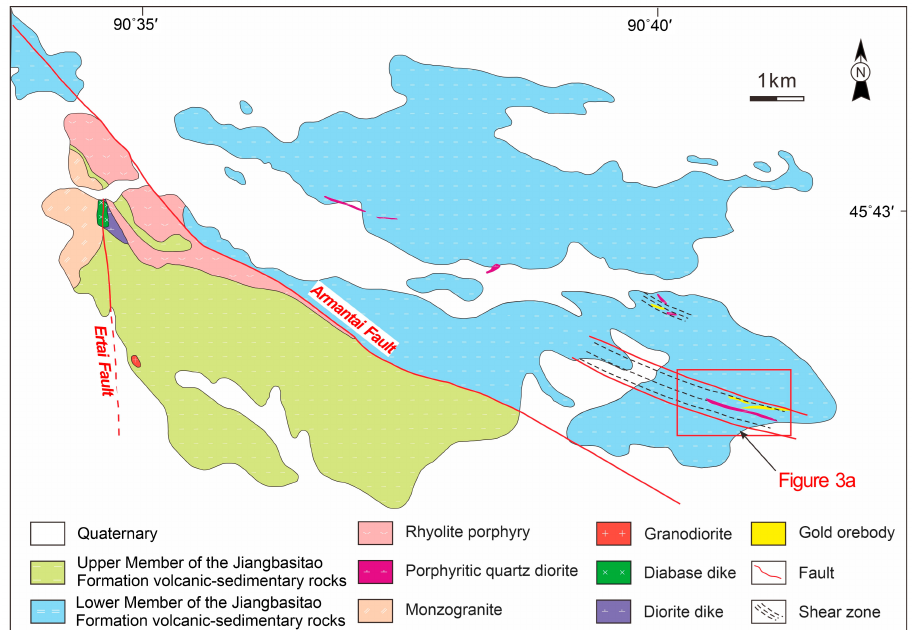
Figure 2. Simplified geological map of Dunbasitao district (according to Liu et al.